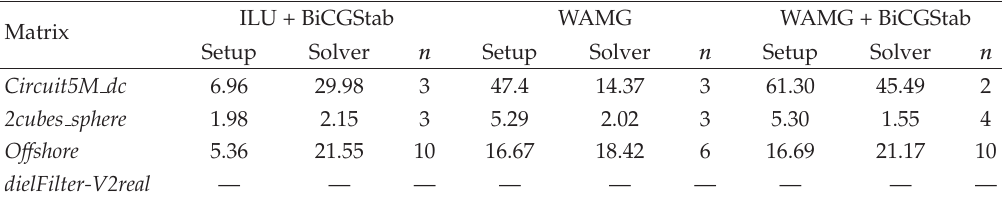
Table 2: Results for sequential tests (cid:2) not enough memory (cid:3)